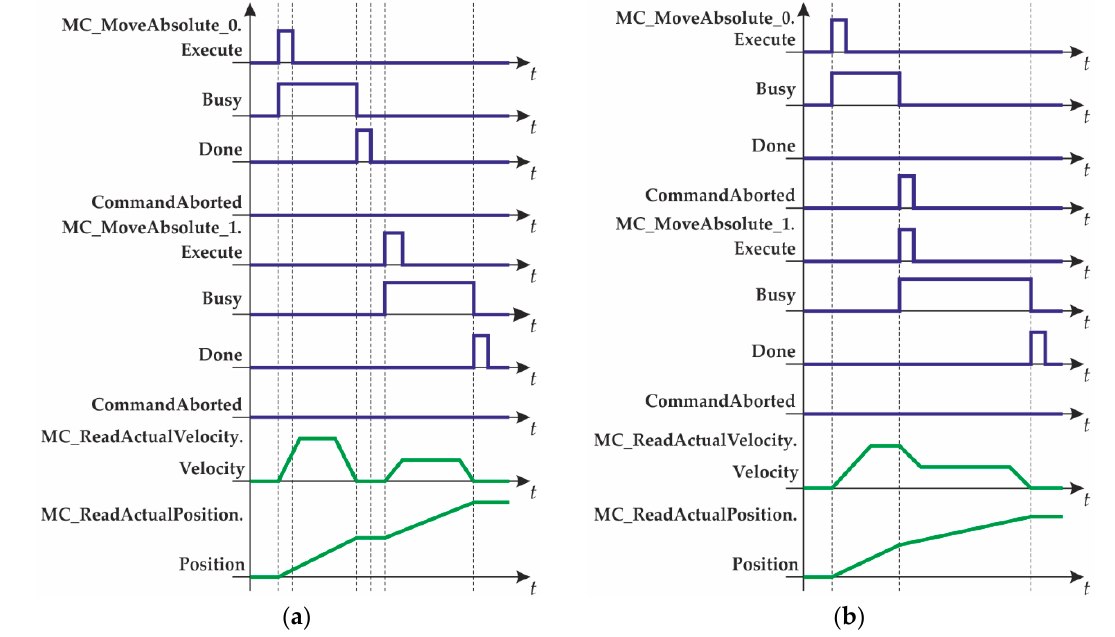
Figure 3. MC_MoveAbsoluteuse() example. ( a ): first use scenario; ( b ): second use scenario.